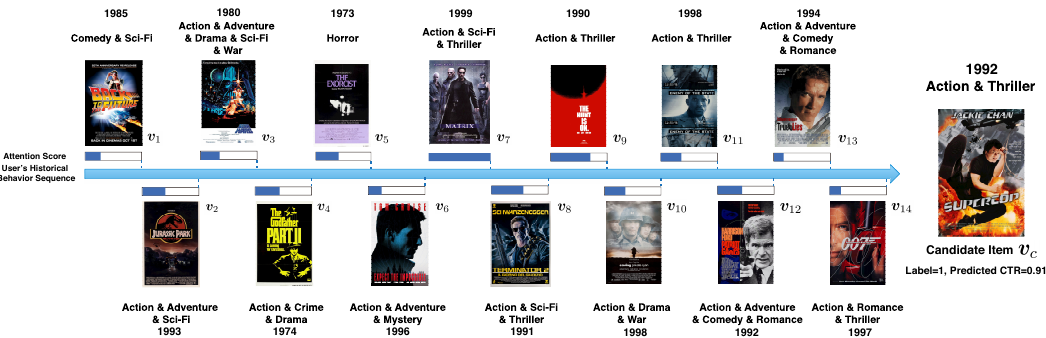
Figure 5. Illustration of the influence of user behavior on the candidate item. The genre and release year of each item are provided. Generally, history items with high relevance to candidate item get high attention